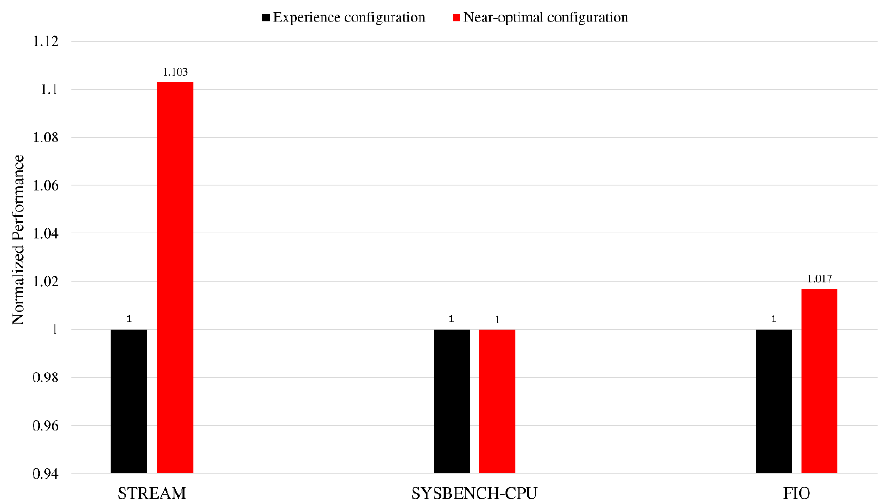
Figure 11. Normalized performance of experience configuration and near-optimal configuration obtained by static offline tuning.